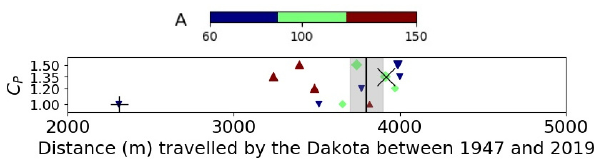
Figure 11. Distance traveled by the Dakota main body along the trajectory line drawn in Fig. 10a for the 12 model runs. The verti- cal line shows the average position of the pieces that were found in 2012, 2015 and 2018, and the shaded area shows its confidence taking into account the delay between the findings and the spread of the objects. Symbols + and × designate the results from the origi- nal model by Compagno et al. (2019), and the best-guess model run among the 12 (Fig. 4), respectively. Large (or small) symbols indi- cate the parameter sets that yielded realistic (or unrealistic) results and then were kept (or discarded) for